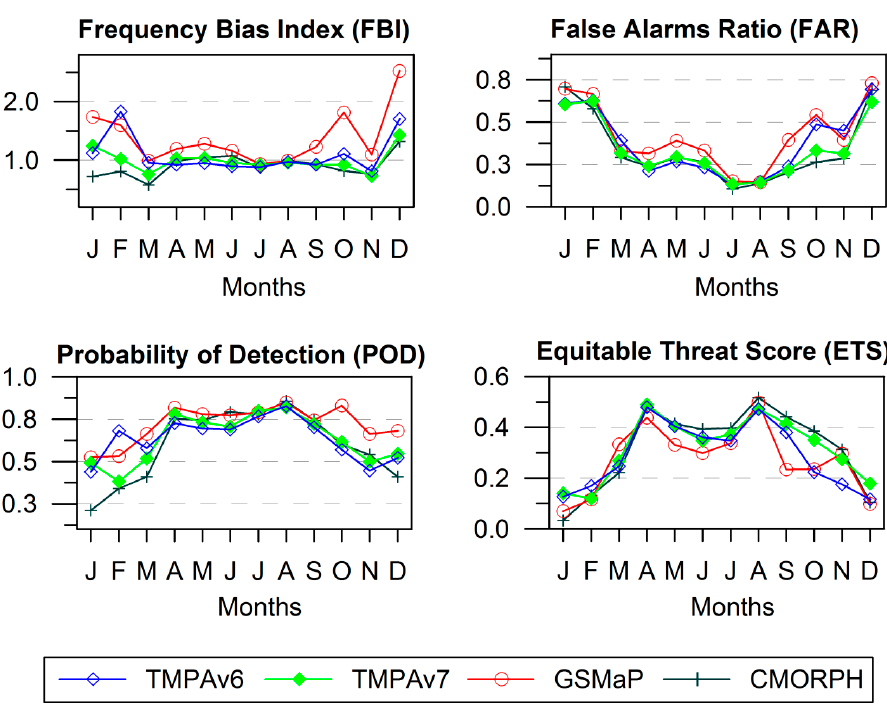
Figure 5. Frequency bias index (FBI), false alarm ratio (FAR), probability of detection (POD), and equitable threat score (ETS) averaged over 2002–2009 for each satellite-derived precipitation product on a monthly scale.